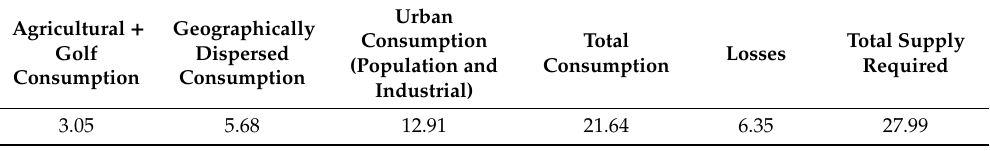
Table 3. Total consumption in Ibiza (hm 3 / year) 2015.